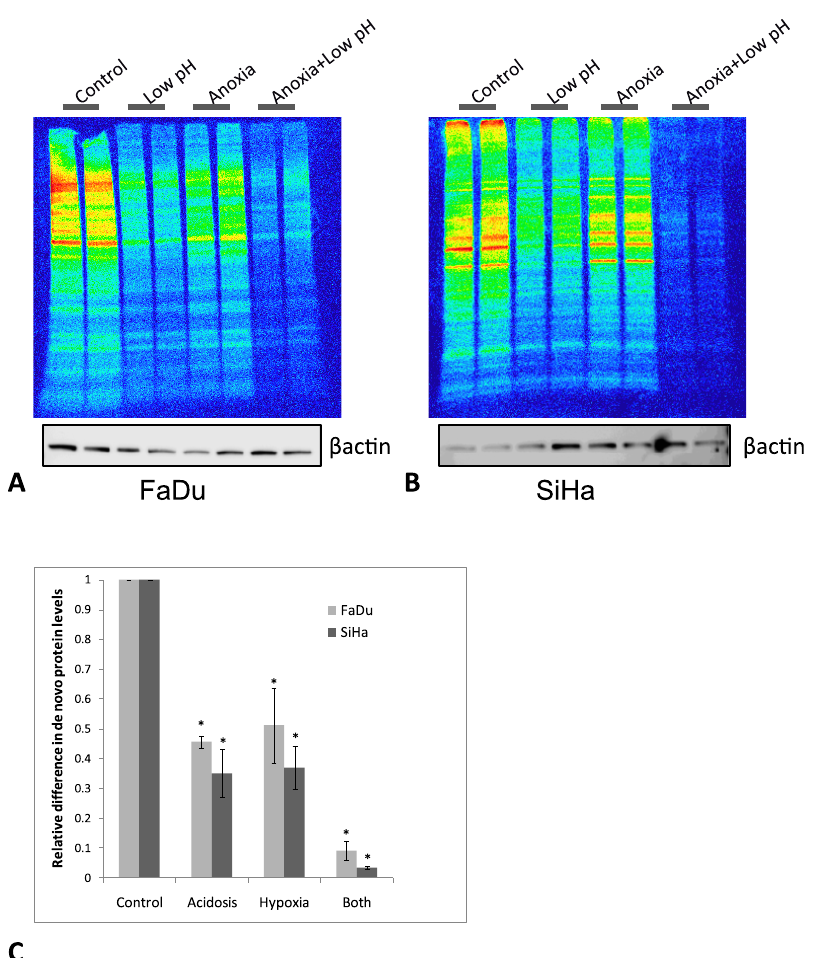
Fig 4. Pulse-labelling assay. To determine whether the cells modified their levels of protein synthesis, 35 S- labelled methionine and cysteine was added during treatment, and de novo protein levels were determined by autoradiography. The gels shown in A (FaDu) and B (SiHa) are representative gels with equal amounts of total protein loaded (two lanes are loaded with each sample). β actin levels was measured on similar gels. C: Mean values from three independent experiments for SiHa and FaDu DD cells (+/-SEM). ( * ) indicates p values < 0.05 compared to the control